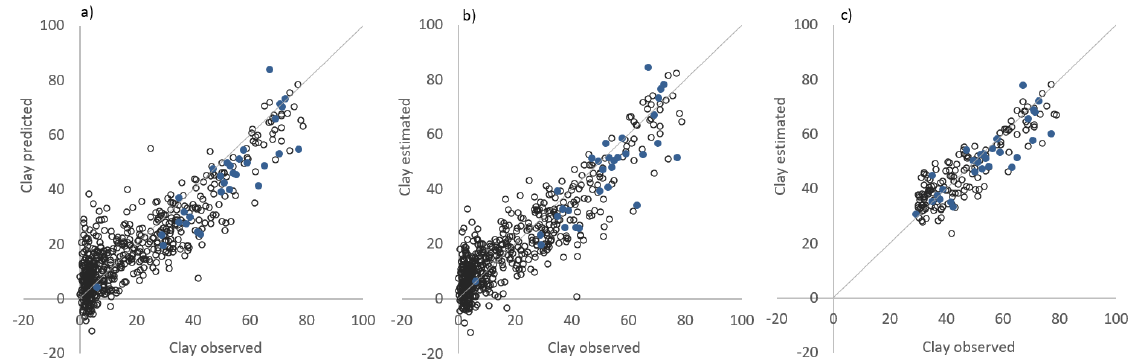
Fig. 6. Predicted clay content (%) in a) all soils, b) coarse-textured and c) clay soils having soil test cations (STCa, cmol l -1 ; STMg, cmol l -1 ; STK, cmol l -1 ) and pH as explanatory variables plotted against observed clay content. Open circles represent the results of the calibration data and blue circles represent the validation data.